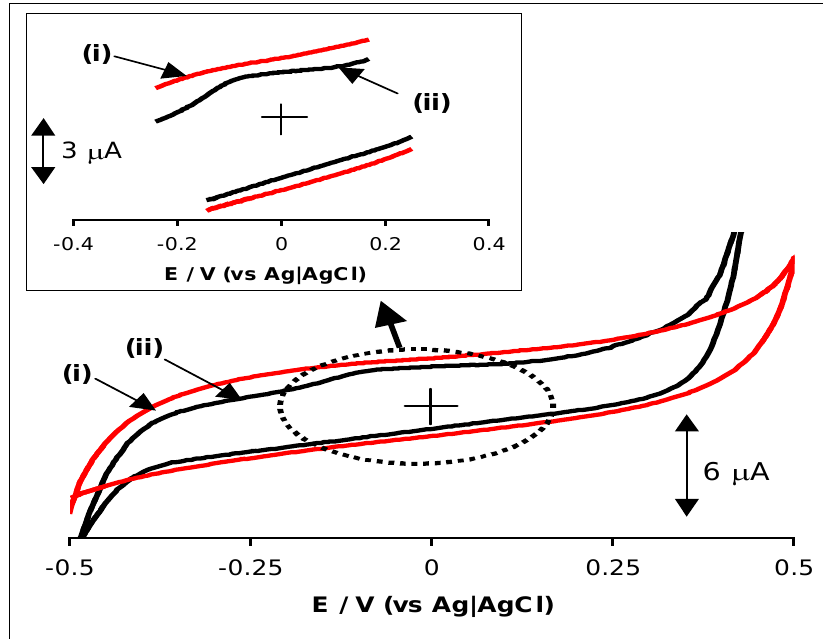
Figure 5: Cyclic voltammograms recorded at (i) bare GCE and (ii) GCE-CoPc-(CoTPP) M NaOH at 25 mVs -1 . Inset shows the Co(II)Pc/Co(III)Pc redox